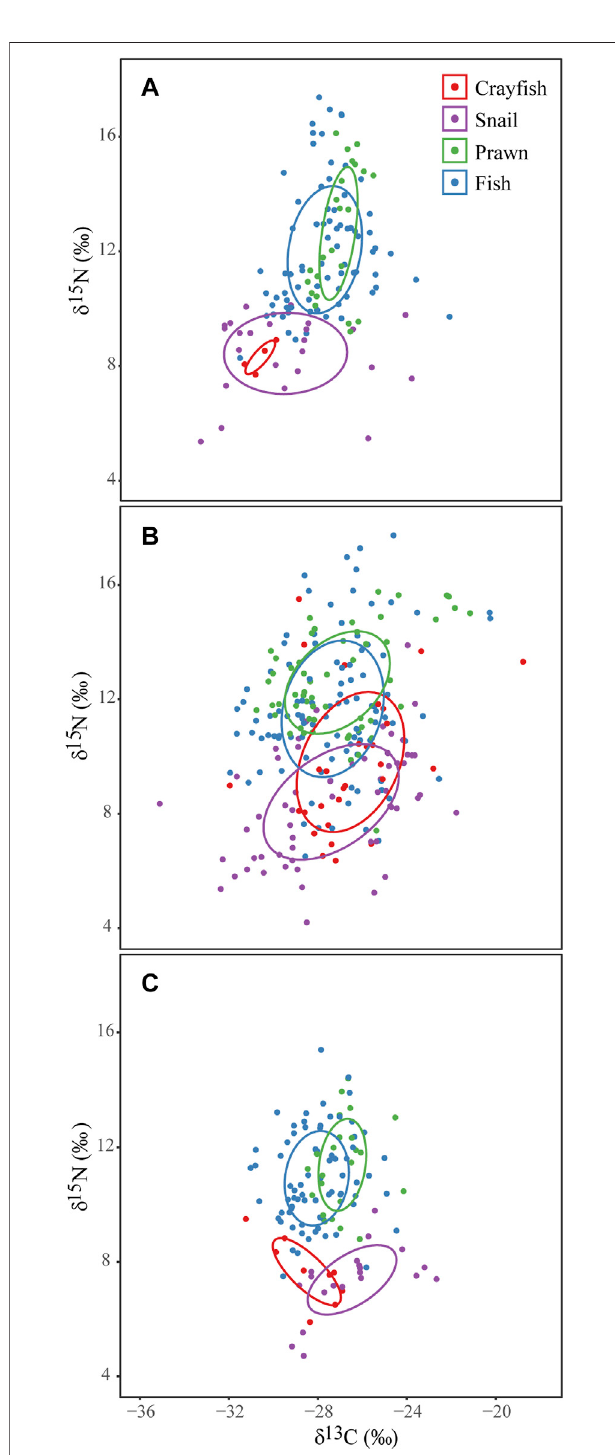
FIGURE 4 | Core isotopic niche areas (SEAc) of four groups in Poyang Lake wetland in May (A) , July (B) and October (C)